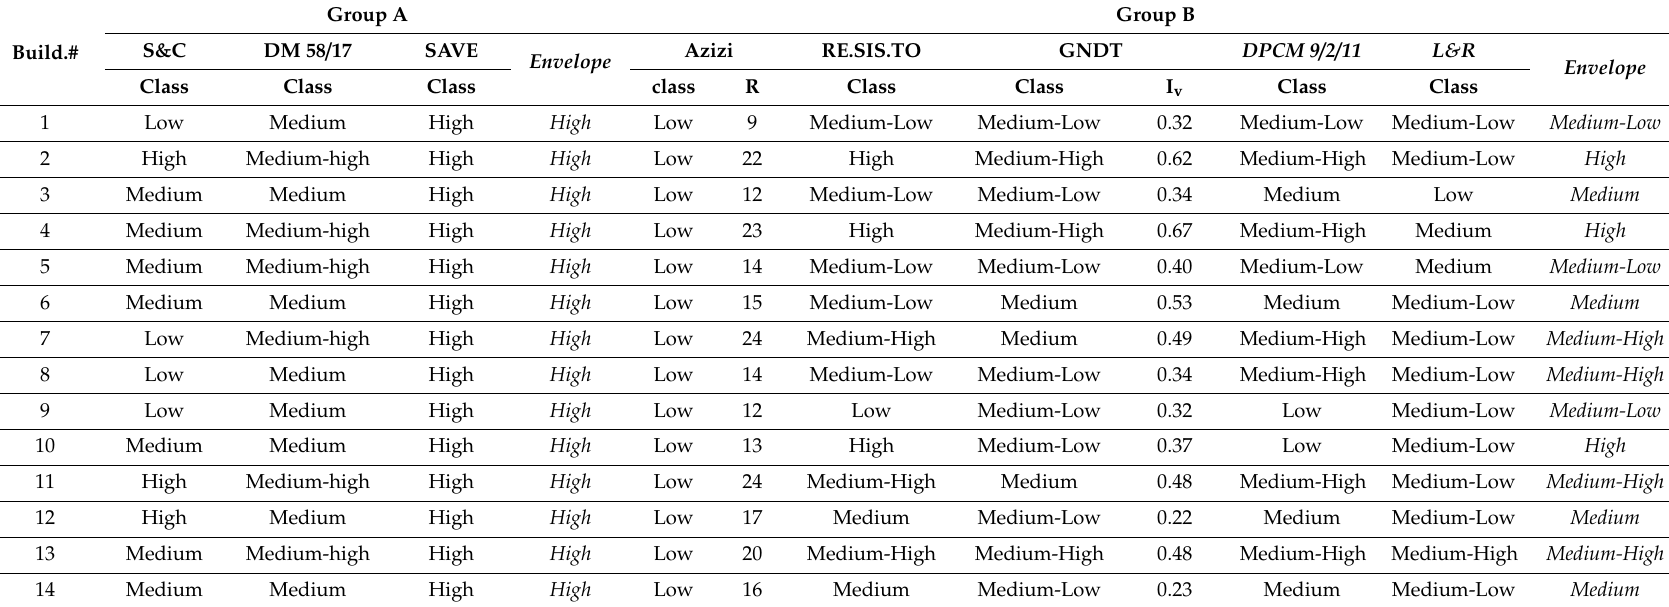
Table 15. Comparison of qualitative vulnerability judgments provided by the methods of Groups A and